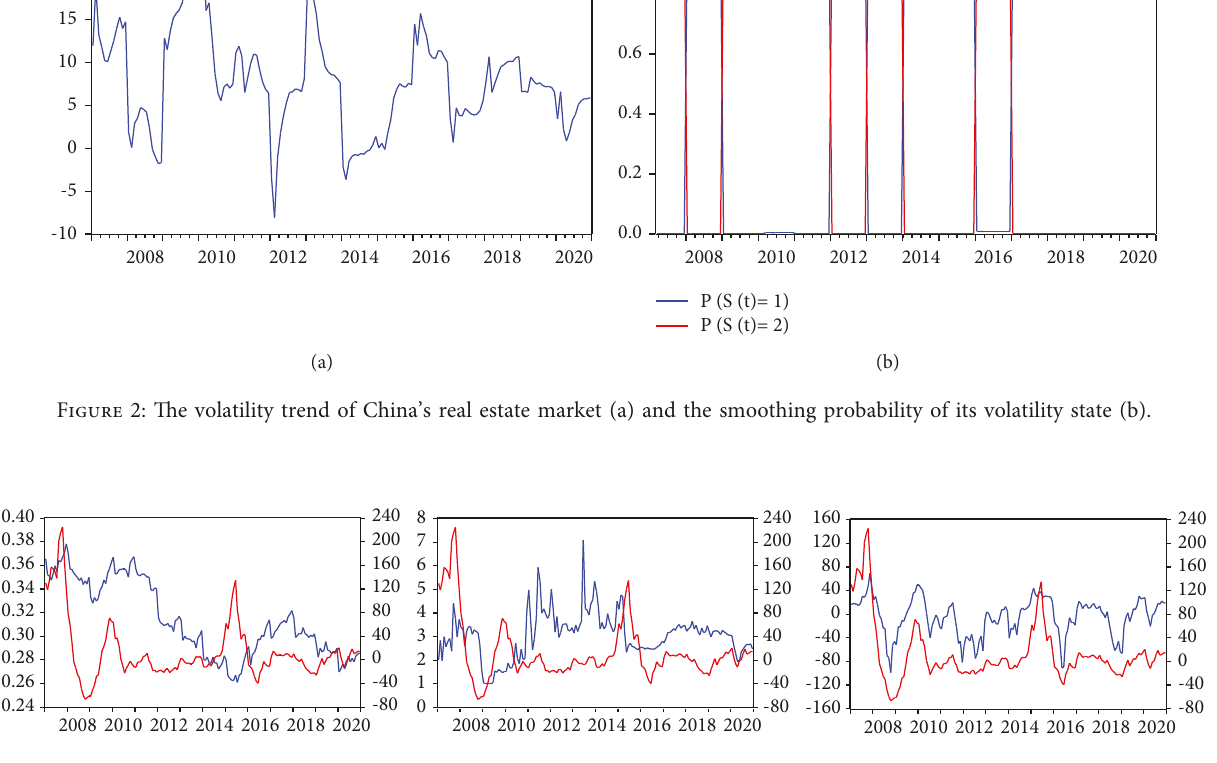
Figure 3: Liquidity characteristics of China’s stock market in the high and low volatility